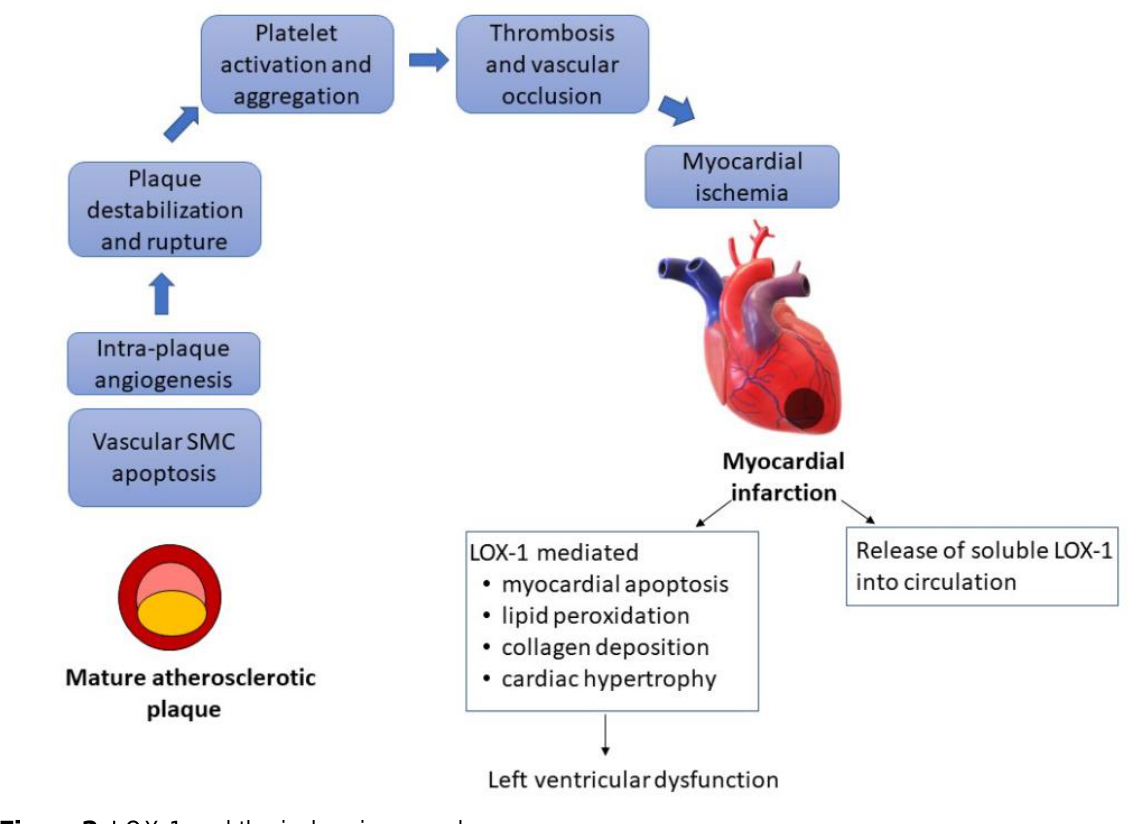
Figure 2: LOX-1 and the ischemic